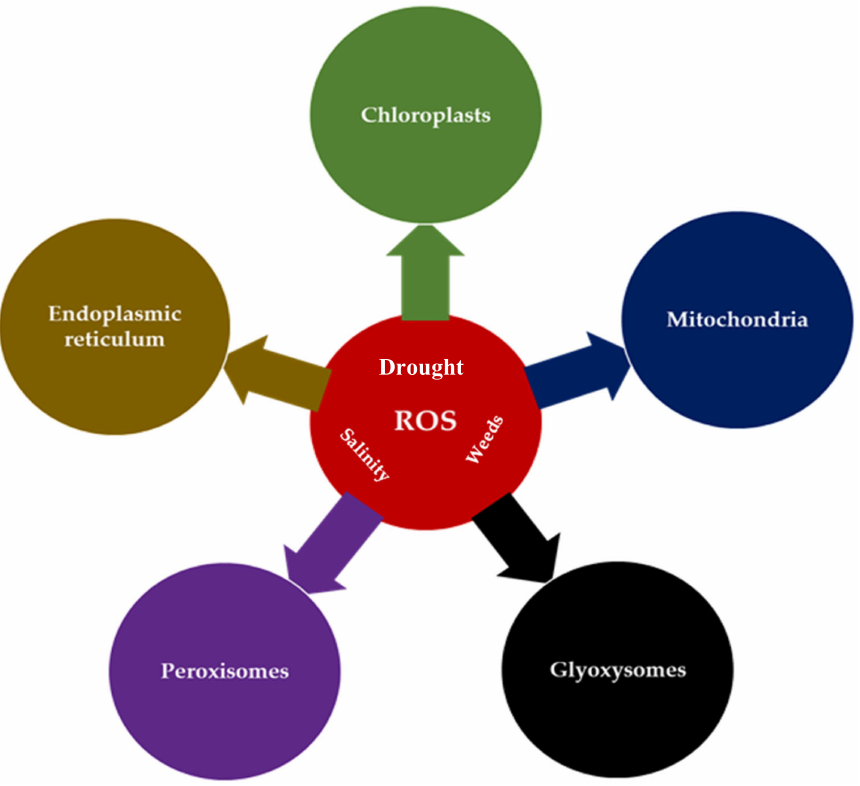
Figure 1. The generation sites of reactive oxygen species in plant cells under natural and stressful